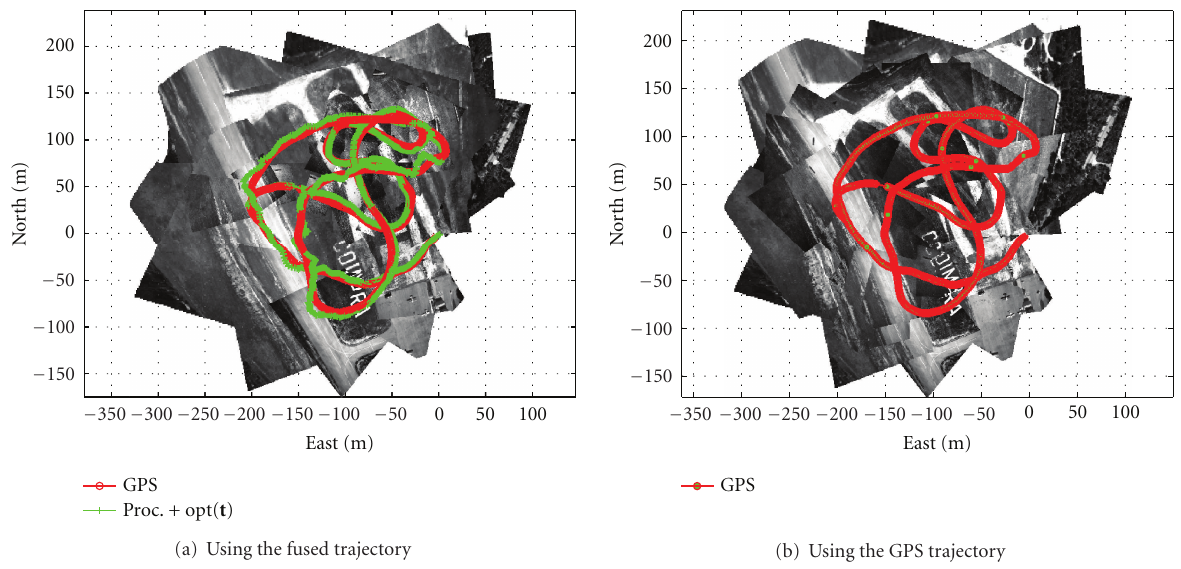
Figure 13: Data from GPS and visual odometry fused by a Kalman filter. The images are projected on the ground plane, forming a map.